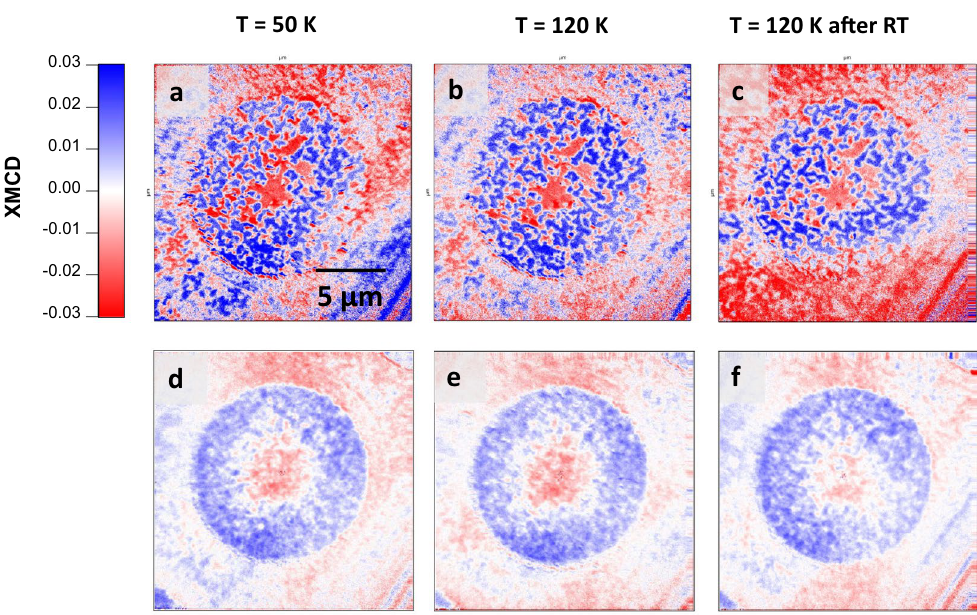
Figure 5. XMCD images for a given circular hybrid SC/FM structure of 13 µm diameter at H ext = 0. ( a ) A magnetic domain configuration with two concentric regions with mostly antiparallel out-of-plane magnetic orientation (blue and red) has been imprinted at 50 K with the help of the SC stray field, see text for details about the magnetic history followed. The imprinted magnetic domain state is stable after increase T above Tc. ( b ) T = 120 K and ( c ) again T = 120 K after keeping the sample 20 min at room temperature ( d–f ) as in ( a–c ) where the XMCD images result from the averaging of the XMCD data obtained for 15